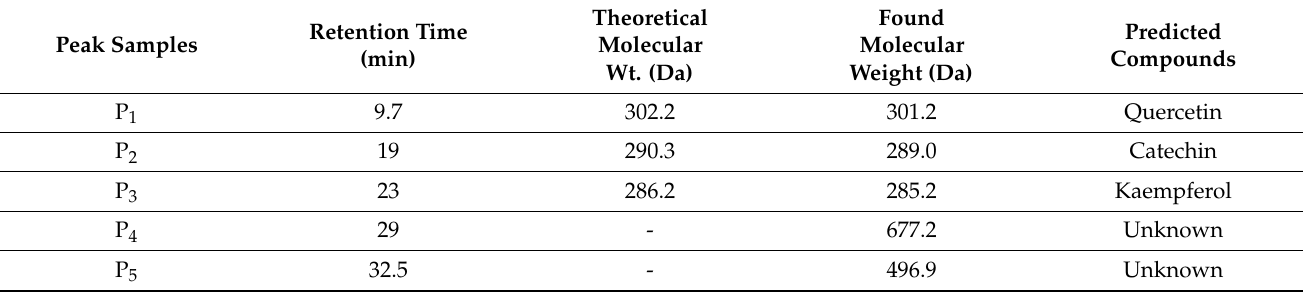
Peaks were separated on a Spectra System LC using a Kinetex 5 μ m F5 LC column (150 × 4.6 mm) (Phenomenex). The mass-to-charge ratio (m/z) versus peak intensity was determined.